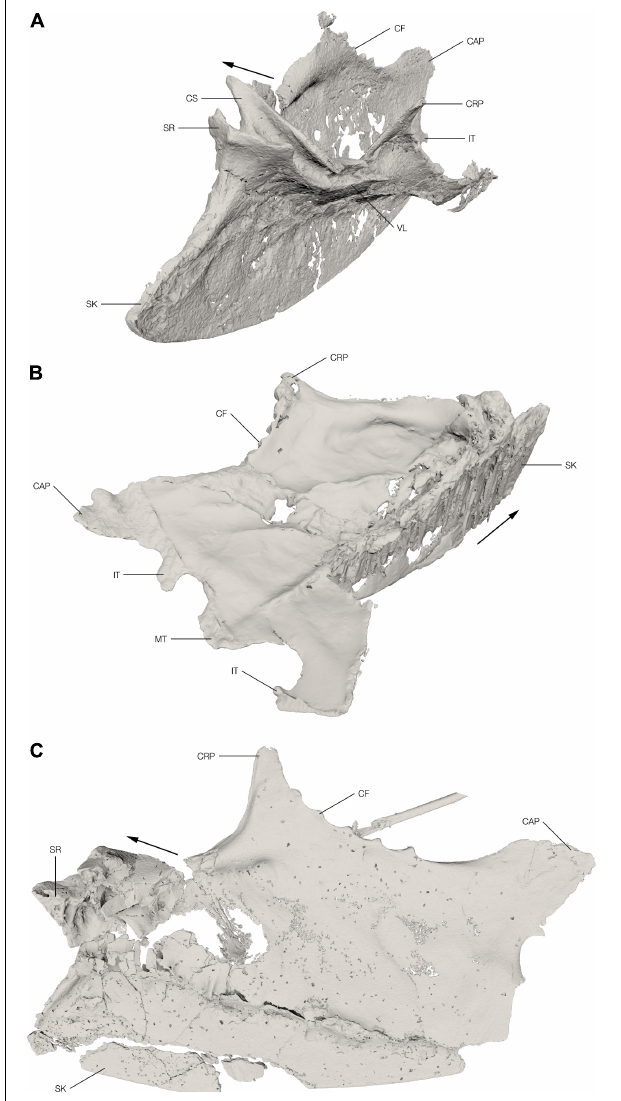
FIGURE 2 | Sterna of the Ichthyornis specimens. Segmented 3D models from the CT scans of the Ichthyornis specimens FHSM VP-18702 (A) in oblique craniolateral view, KUVP 119673 (B) in oblique caudodorsal view and NHMUK PV A 905 (C) in oblique dorsolateral view. The cranial direction is indicated with an arrow for each of the specimens. CAP, caudolateral process; CF, costal facet; CRP, craniolateral process; CS, coracoid sulcus; IT, intermediate trabecula; MT, median trabecula; SK, sternal keel; SR, sternal rostrum; VL, ventral lip.